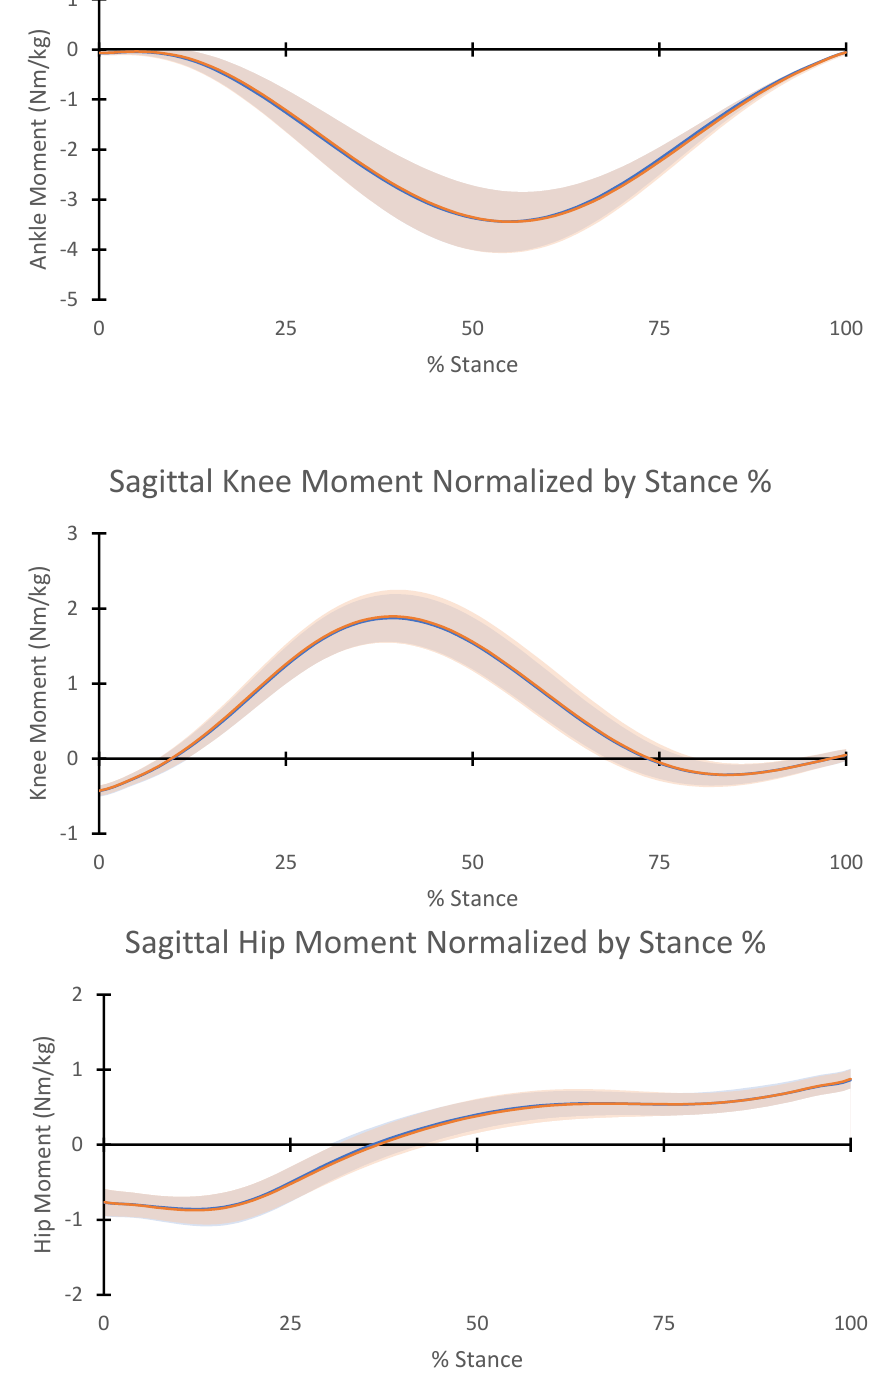
Figure 3. Comparison of the ankle, knee, and hip sagittal plane moments normalized by % stance.